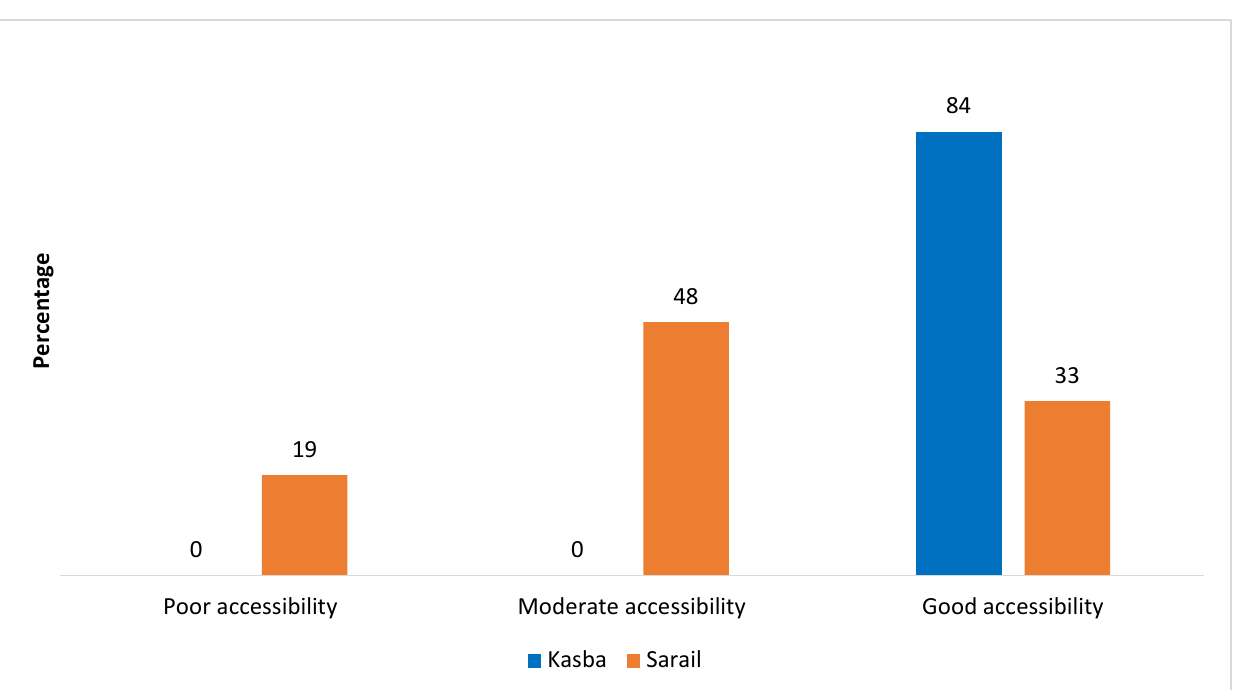
Figure 3. Readiness status of CCs at Kasba (n = 33) and Sarail (n = 21).